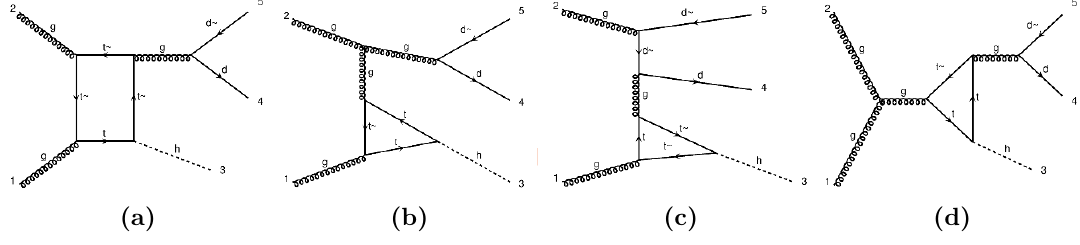
Figure 3 . Diagrams building the amplitude A (2 ; 0) against which the diagrams listed in (cid:12)gure 1 gg ! Hq (cid:22) q are interfered to yield (cid:27) (1 ; 1) . The full top-quark mass dependence is gg ! Hq (cid:22) q